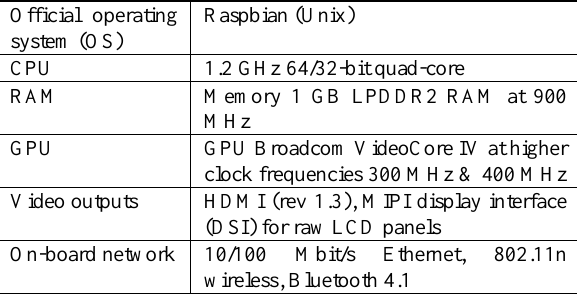
Table 2. Raspberry Pi3 Model B main characteristics.